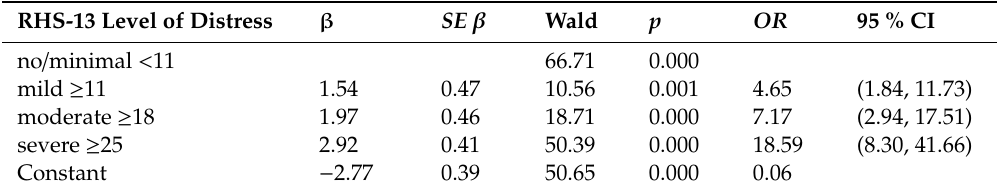
Table 2. Regression analysis of suicidal ideation at di ff erent levels of